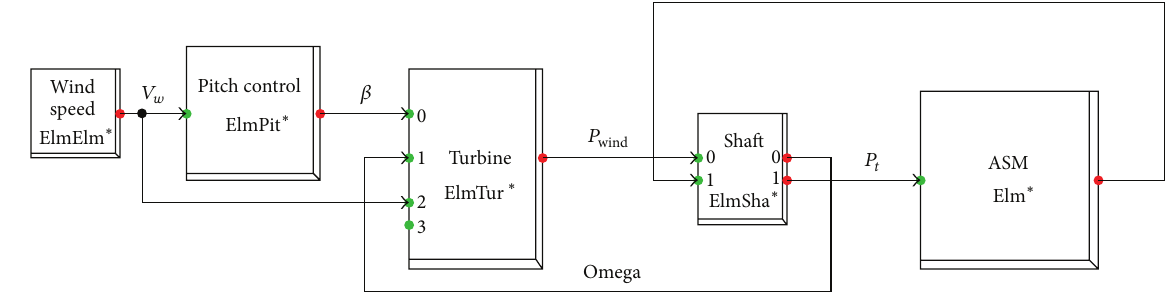
Figure 5: FSWES model in DIgSILENT.